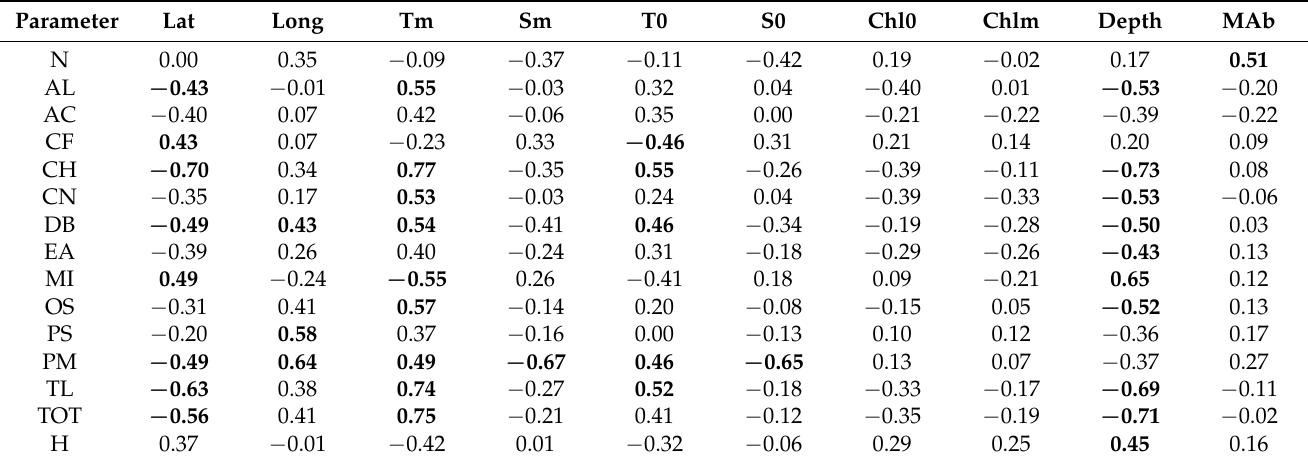
Table 5. Pearson correlations between environmental parameters and biotic variables in the south- eastern Barents Sea in summer 2012. Bold font indicates significant correlation coefficient ( p < 0.05). For abbreviations, see Figure